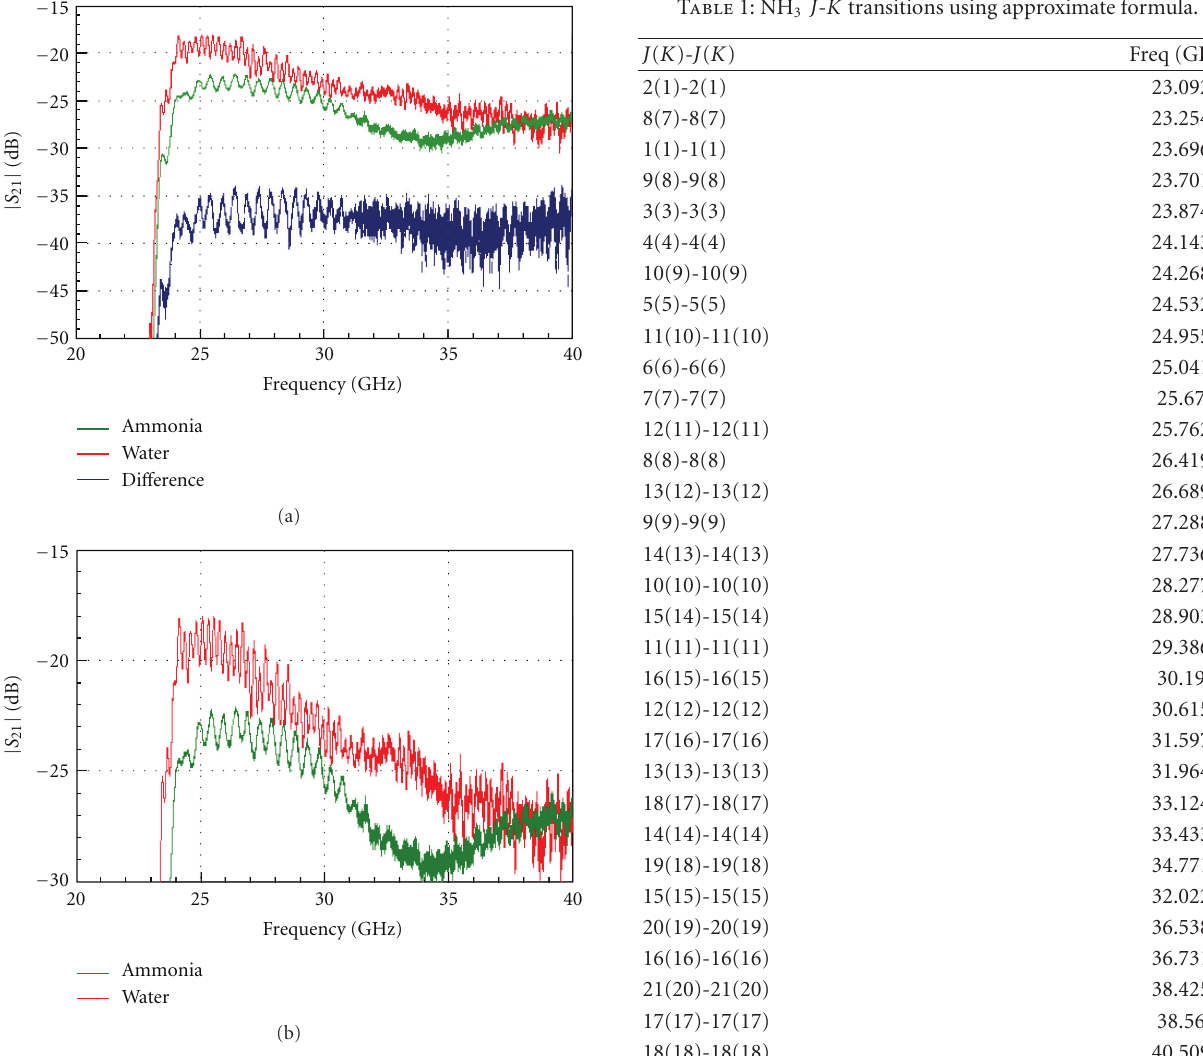
Table 1: NH 3 J - K transitions using approximate